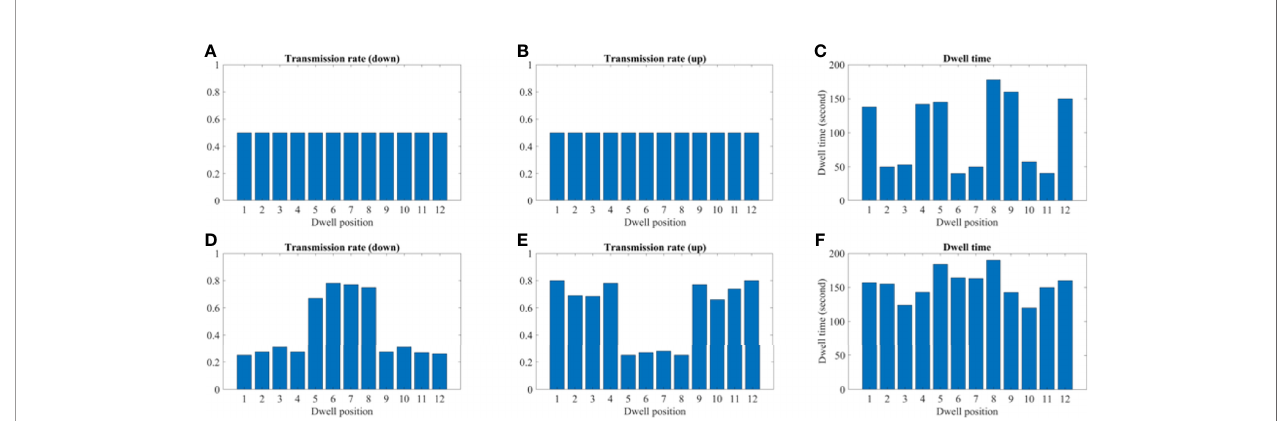
FIGURE 10 | A comparison between the conventional method and proposed using the 2D patient model. (A – C) A transmission and dwell time for the conventional method. (D – F) A transmission and dwell time for the proposed method. To compare the proposed method with the conventional one, we use the same model and solver, but we fi x the transmission rates as constant (= 1.0).